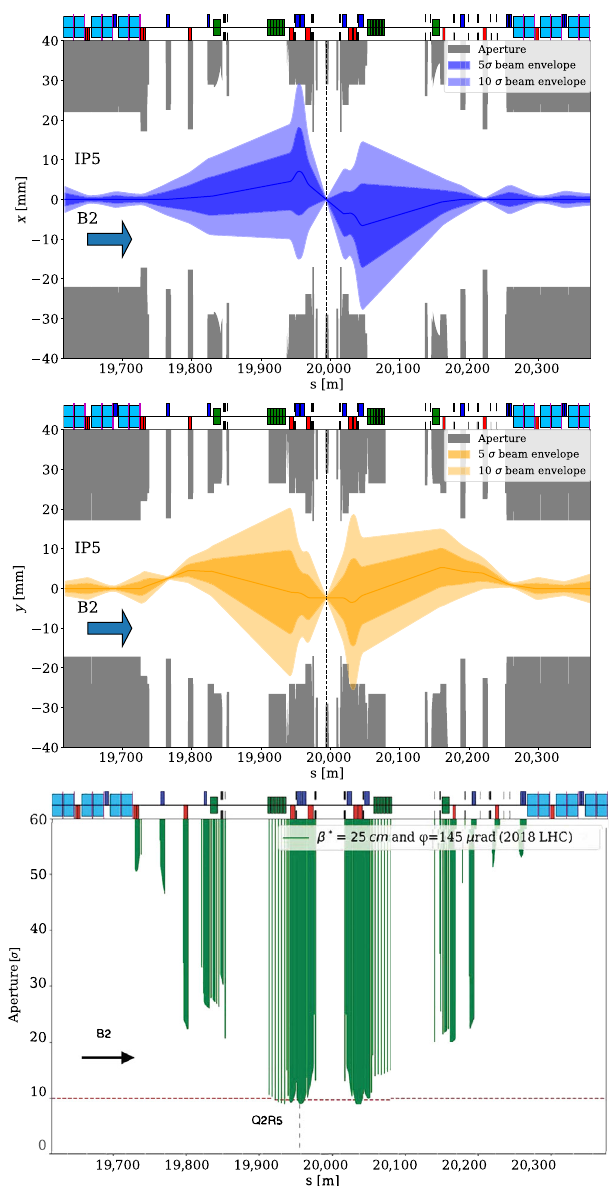
and 5 and 10 σ beam envelopes for the 2018 optics with a β (cid:2) x;y of 25 cm and a half-crossing angle of 145 μ rad. The geometrical aperture model is also plotted and the machine layout is depicted on the top of the plots with dipoles in light blue, focusing quadrupoles in blue, defocusing quadrupoles in red, sextupoles in green, and collimators in black. The bottom plot shows an example of the aperture calculated with the MAD - X algorithm in units of σ . A red line was added for reference at 10 σ .